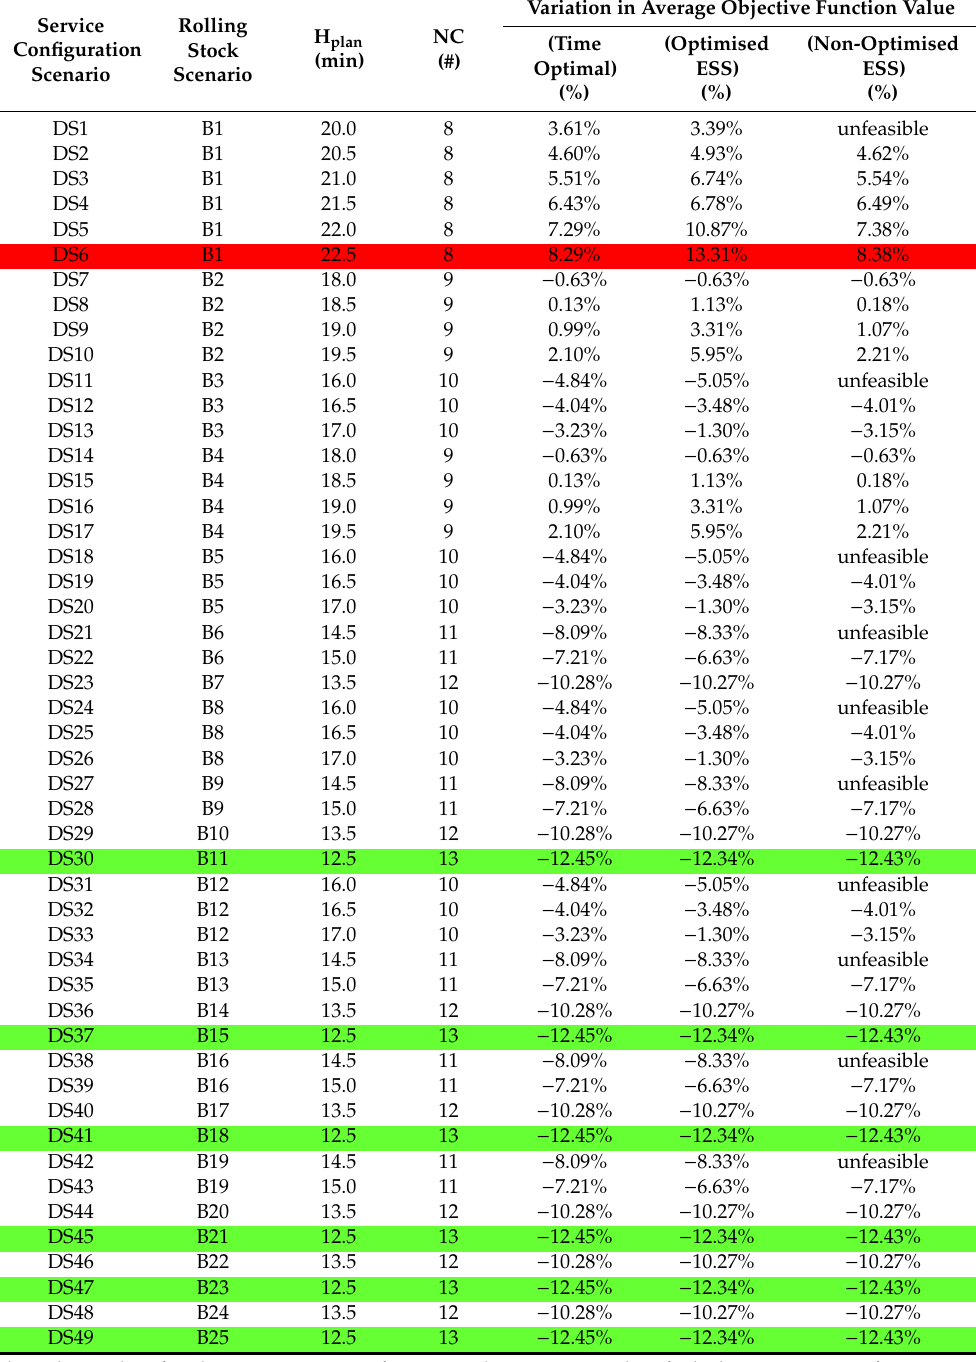
Table A4. Intervention scenario improvements in disrupted